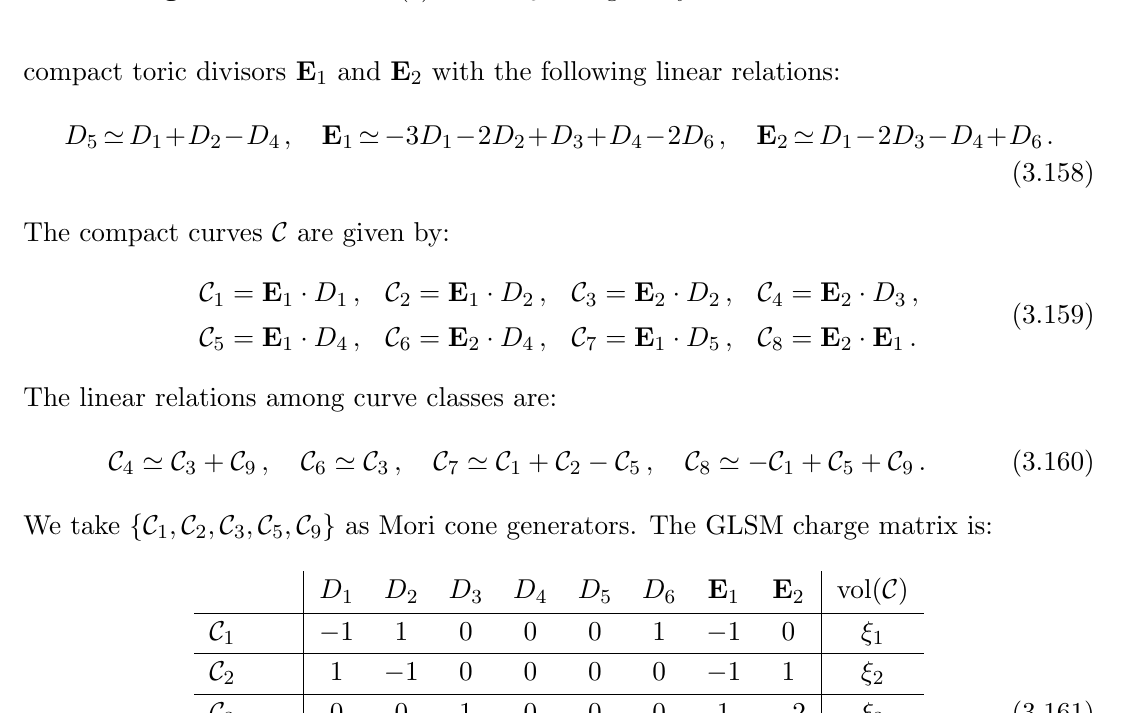
Figure 29 . Resolution (a) of the E 32 ; 1 singularity and its vertical